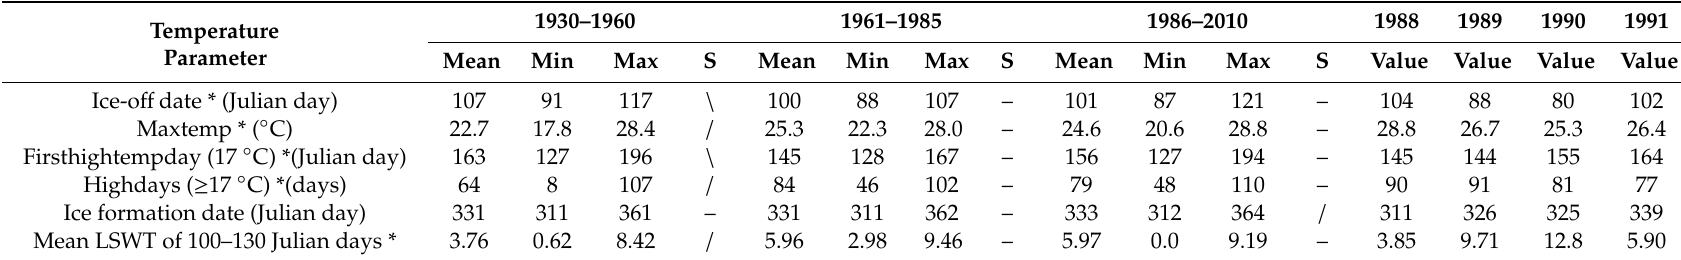
Table 3. Statistical characteristics of selected water temperature parameters for the periods 1930–1960, 1961–1985 and 1986–2010 and for the years of vendace collapse in Lake